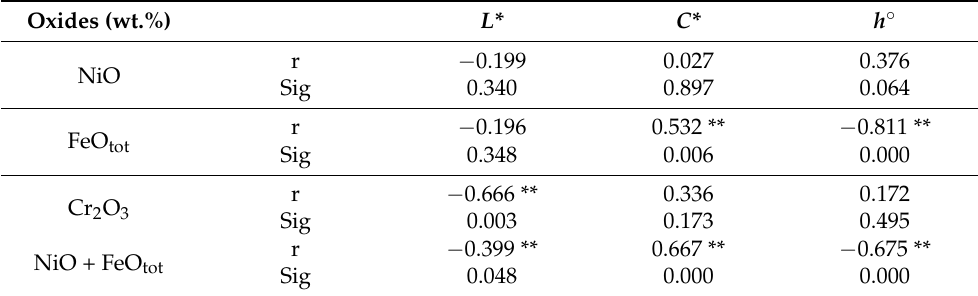
Table 2. Results of bivariate correlation analysis. ** At level 0.01 (double tail), the correlation was